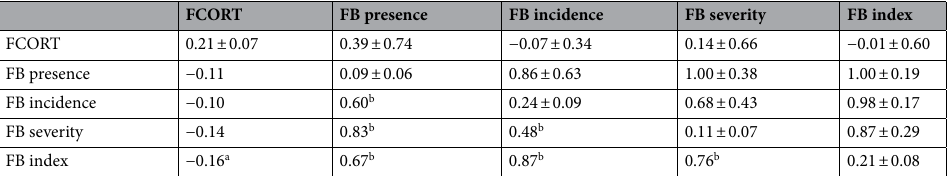
Table 2. Genetic and partial phenotypic correlations of feather corticosterone (FCORT) and fault bar (FB) traits with growth and efficiency traits in turkeys (N = 408–1130 depending on trait). Growth and efficiency traits include body weight at 12 weeks of age (BW12, kg), body weight just prior to slaughter (BW20, kg), walking score (WS20), and feed conversion ratio (FCR). 1 Significant partial phenotypic correlations are denoted by letter superscripts where a = p < 0.05 and b = p <